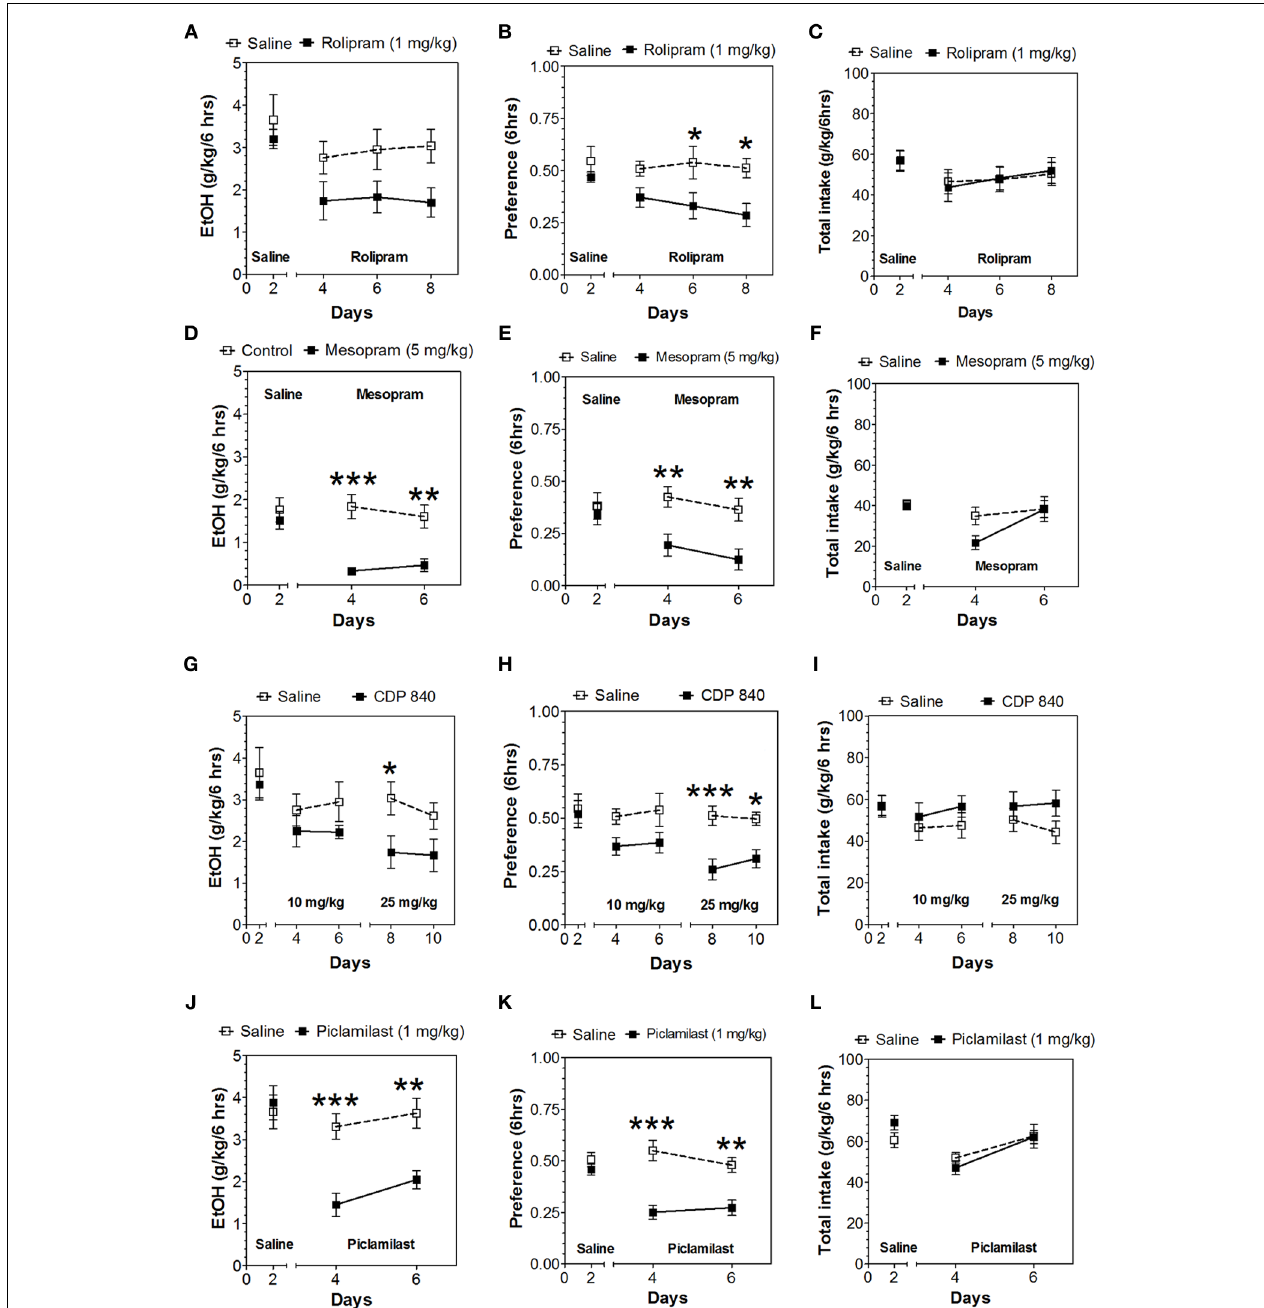
FIGURE 1 | PDE4 inhibitors reduce alcohol intake during the first 6h of the 24-h two-bottle choice paradigm. Ethanol consumption is presented as g/kg/6h: (A) Rolipram (D) Mesopram (G) CDP840 (J) Piclamilast. Preference for ethanol: (B) Rolipram (E) Mesopram (H) CDP840 (K) Piclamilast. Total